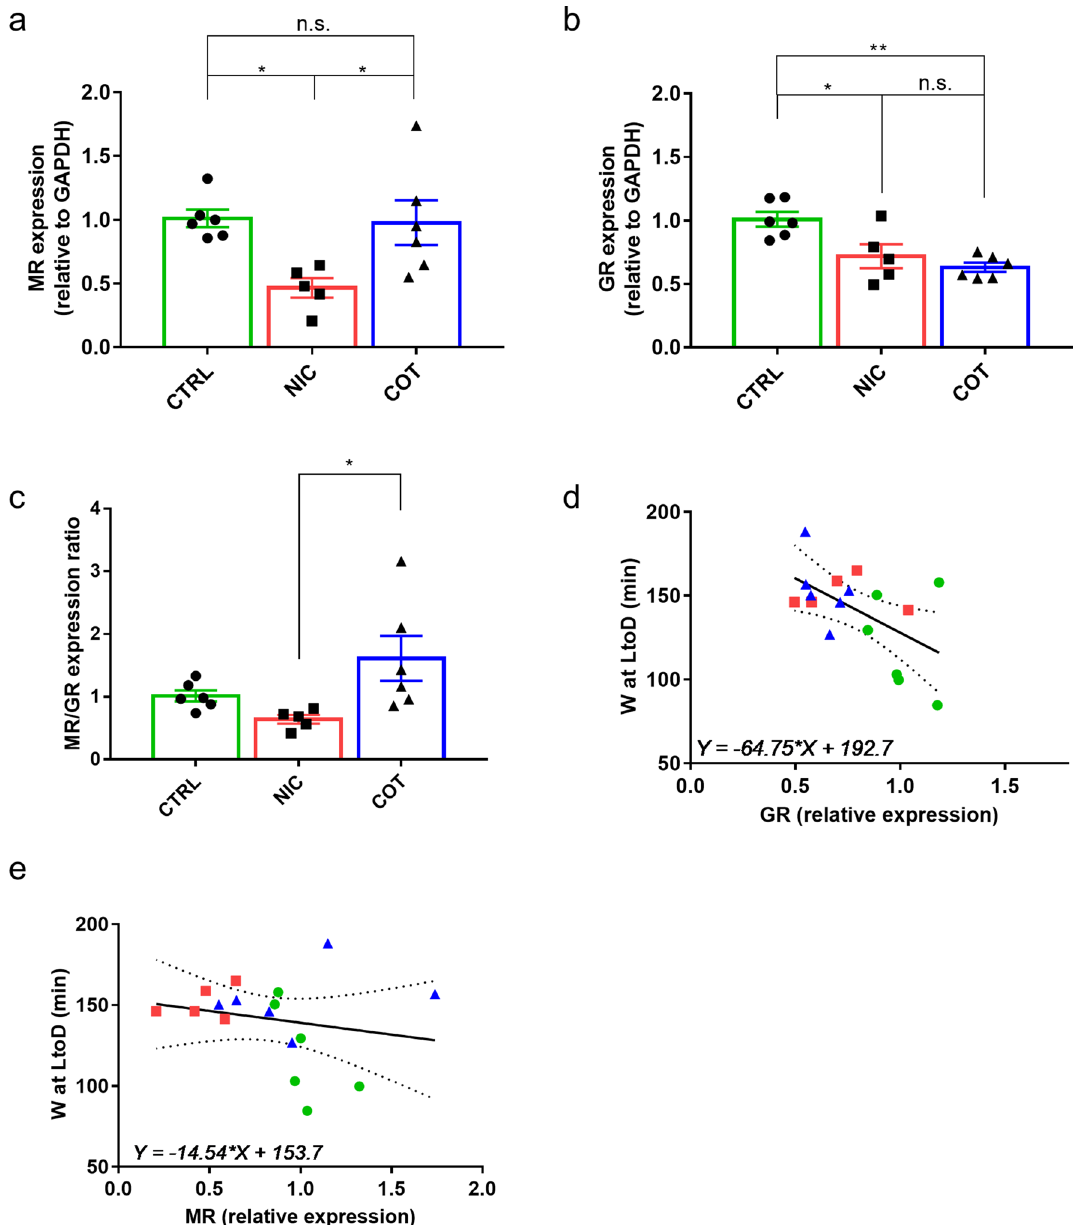
Figure 5. Corticosteroid receptor gene expression in hippocampus. Panel ( a , b ) show the expression of hippocampal GR (Nr3c1) and MR (Nr3c2) genes relative to the expression of glyceraldehyde-3-phosphate dehydrogenase (Gapdh), used as reference gene. Panel ( c ) shows the expression ratio of MR and GR genes. Panels ( d , e ) show the correlation between the relative hippocampal GR (panel d ) or MR (panel e ) expression (x-axis) and the amount of wakefulness (W) at light to dark (LtoD) transition (y-axis) considering all the mice of the present experiment. Continuous and dotted lines indicate the regression line and the 95% confidence, respectively. All data refer to adult male mice perinatally exposed to nicotine (NIC, n = 5), cotinine (COT, n = 6) or just the vehicle (CTRL, n = 6). * p (adjusted for multiple comparisons) < 0.05; ** p (adjusted for multiple comparisons) < 0.01; n.s., not